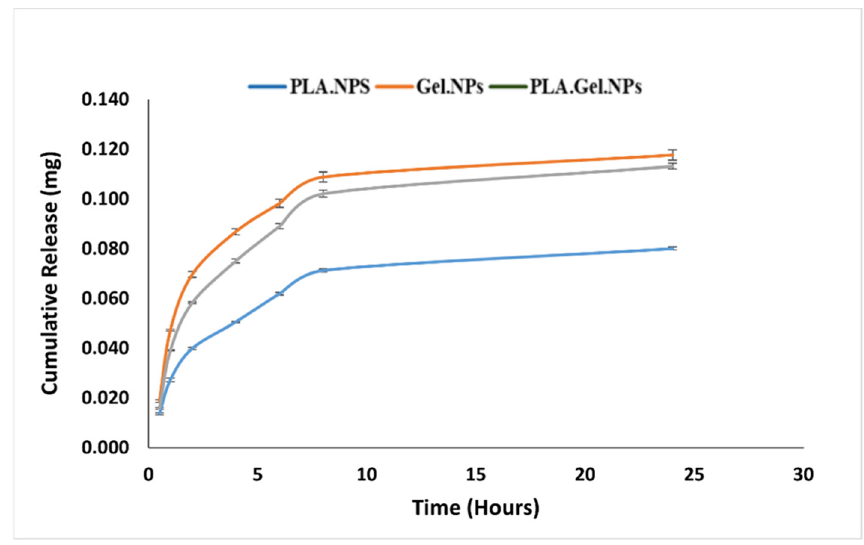
Figure 4. SNPs release profiles from different textiles.